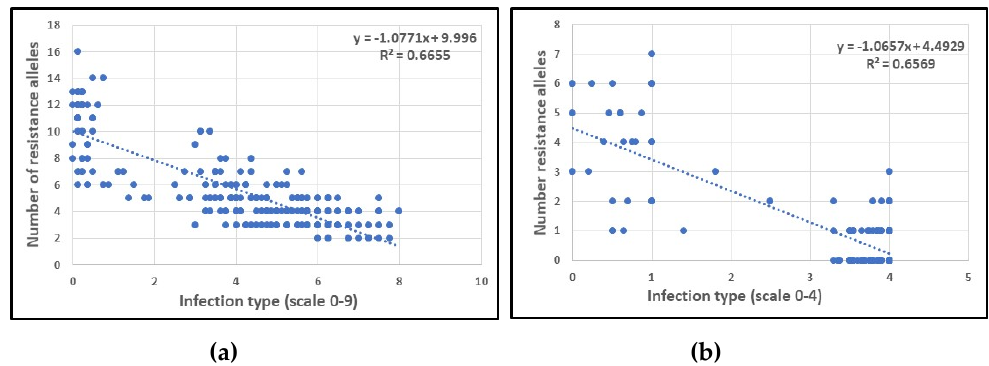
Figure 3. Linear regression of powdery mildew response of adult plants (a) and seedlings (b) to number of resistance alleles of QTL-tagging SNPs in each accession of the tetraploid wheat collection.